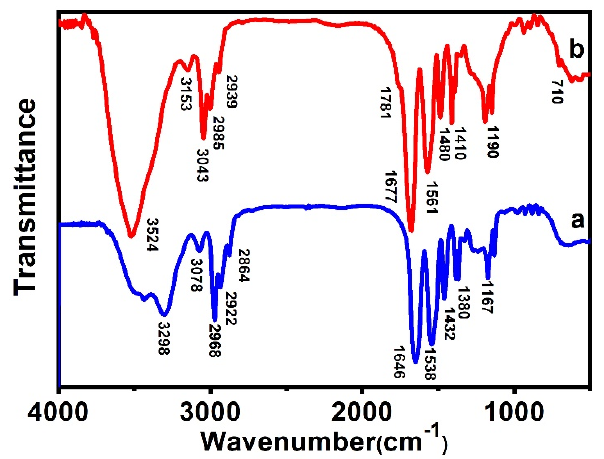
Figure 5. FT-IR spectra of PNIPAM (a) and block polymer PNIPAM- b -P(St- co -MQ)